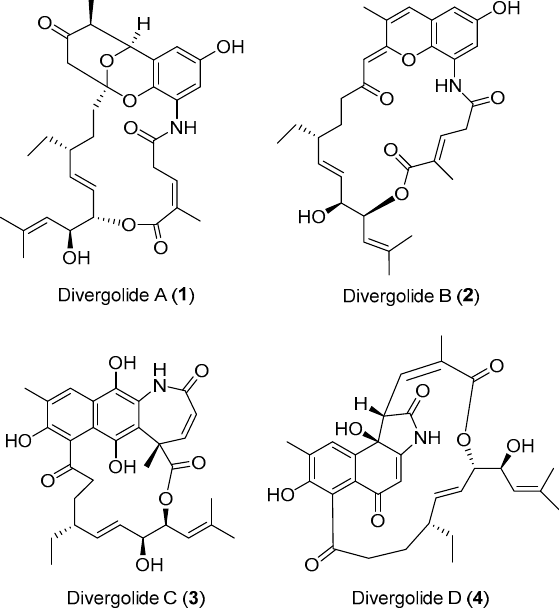
Figure 1. Structures of divergolides A–D ( 1 – 4 ).